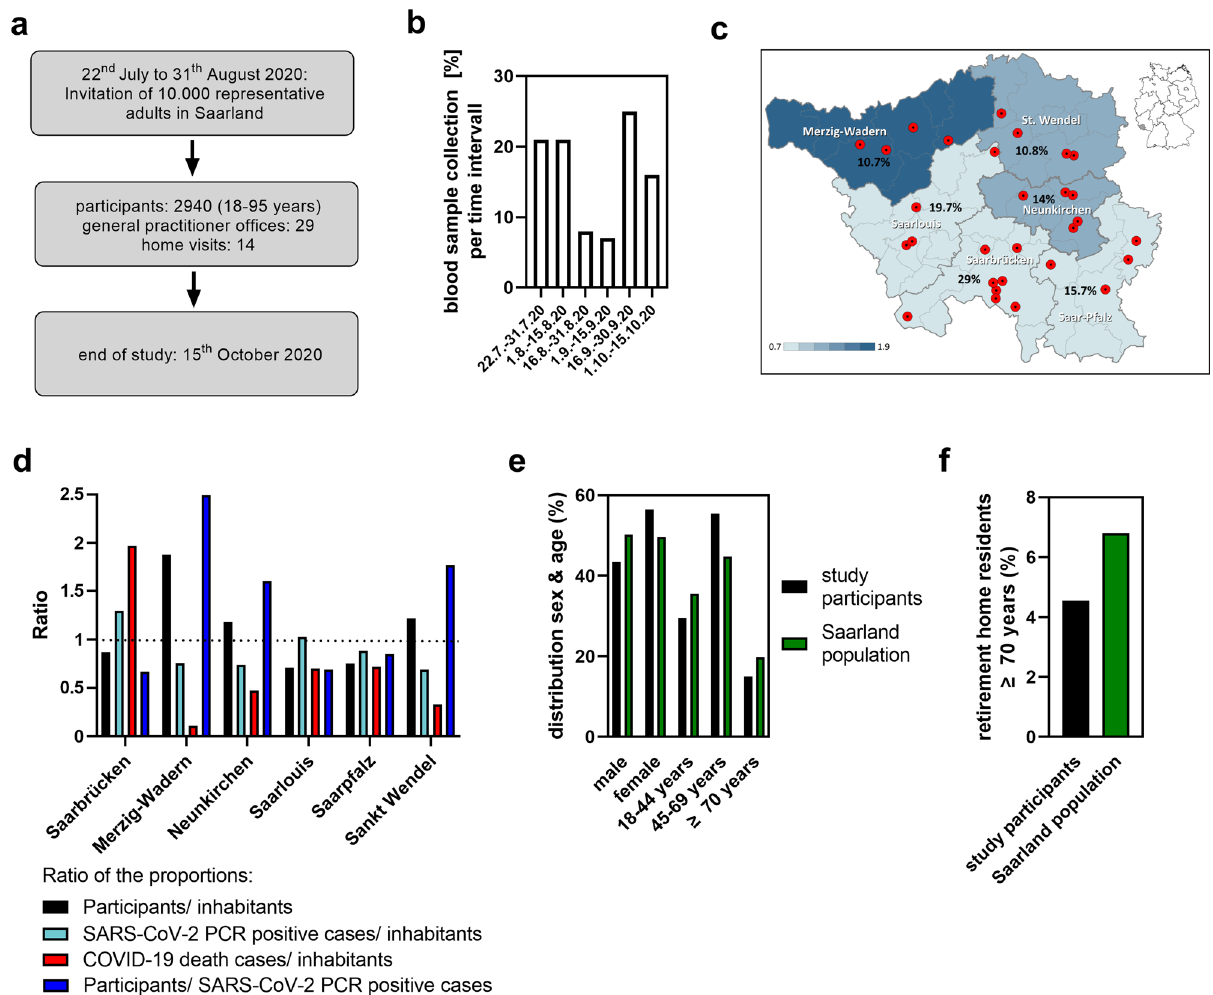
Fig. 4 Study design and composition of the study population. a Time scale of study enrollment. b Percentages of blood samples from study participants collected during the indicated time frames of the study. c Numbers (%) indicate the proportion of study participants from respective administrative districts. The color graduation indicates the relative representation of the resident district population within the study population from 0.7 to 1.9 in steps of 0.2. Administrative boundaries from © GeoBasis-DE / BKG (2020), Data licence Germany — attribution — version 2.0. d Shown is the quotient of the relative proportions of study participants per district (black), SARS-CoV-2 PCR-positive cases per district (light blue), COVID-19 death cases per district (red), respectively, and the relative proportion of residents in that district, or the quotient of the relative proportion of study participants per district (blue) and the relative proportion of SARS-CoV-2 PCR-positive cases per district by October 15, 2020. e Sex and age characteristics of study participants in relation to the resident population (Supplementary Table 1). f Proportion of individuals aged 70 years or older living in nursing or retirement homes in the study sample and the overall population 25